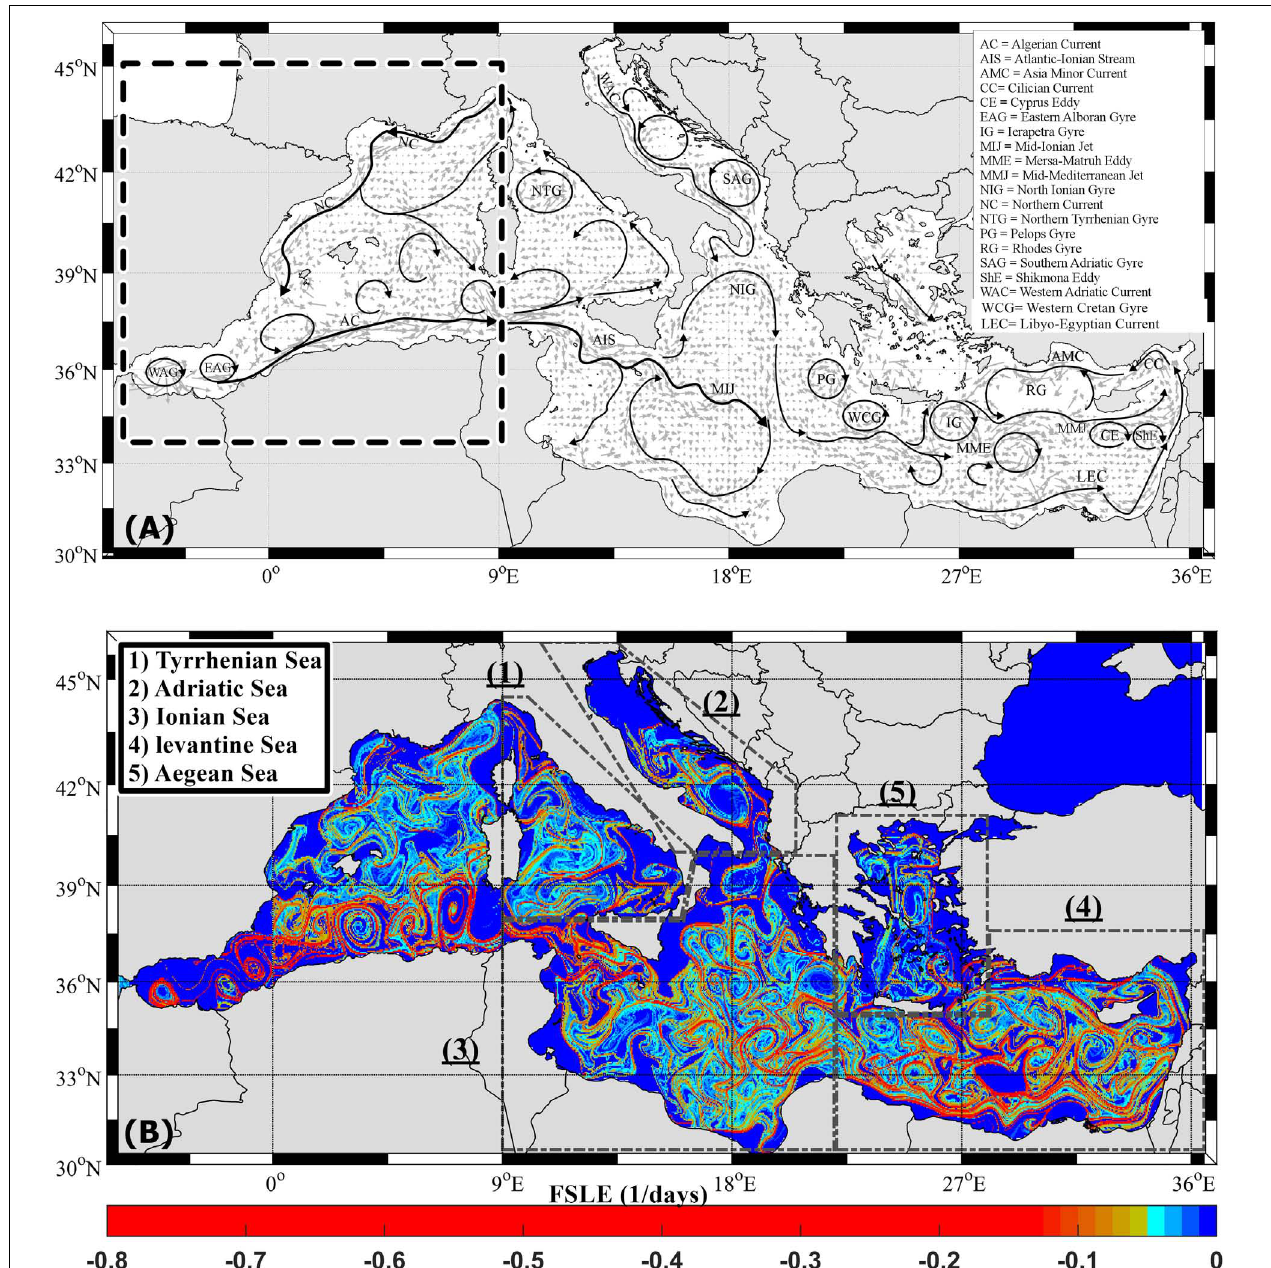
FIGURE 1 | (A) The mean surface circulation and the major circulation features in the Mediterranean Sea in bin of 0.25 × 0.25 ◦ using the available historical drifter dataset adapted from Poulain et al. (2012b) and Menna et al. (2013). The black dashed rectangle shows the geographic limits of the WWM discussed in Bouzaiene et al. (2018). The major circulation features are listed in the inset. (B) Snapshots of the FSLE in the Mediterranean sub-basins: in July 2012 and 2018 for the WWM; in January 2019 for the Tyrrhenian, Ionian, and Levantine sub-basins; in January 2015 for the Adriatic and in January 2018 for the Aegean sub-basin. The polygons show the geographical locations of the Mediterranean sub-basins considered in this